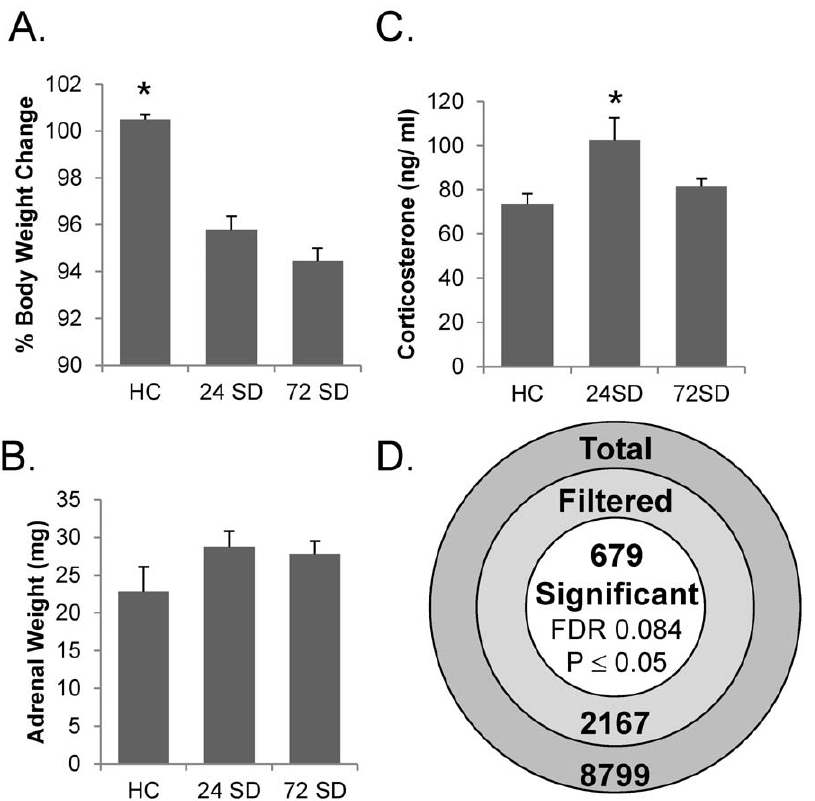
Figure 1. Sleep deprivation reduces body weight, increases corticosterone, and causes detectable changes in hippocampal gene expression. A. Body weight was significantly reduced in all SD animals from both cohorts. Weights measured at the end of the study are expressed as a percentage of the body weight measured at the beginning of the study, a 4 day span (1-way ANOVA [* F 2, 49 =29.1, p =4.8 6 10 2 9 ]). B. Adrenal weights measured from animals in cohort 1(HC n =9; 24SD n =9; 72SD n =10) were not significantly increased (p =0.22). C. Corticosterone levels from animals in cohort 2 (HC n =12; 24SD n =9; 72SD n =13) were significantly increased at 24SD (1-way ANOVA [F 2,31 =5.93, p =0.0066]; *post-hoc Tukeys). D. Of 8799 total probe sets, 2167 were rated present and had unique gene symbol level annotations. These were tested by 1-way ANOVA across HC, 24SD, and 72SD groups. A total of 679 genes were rated significant (p # 0.05). The False discovery rate (FDR) procedure estimates that 8.4% of these results are significant due to the error of multiple